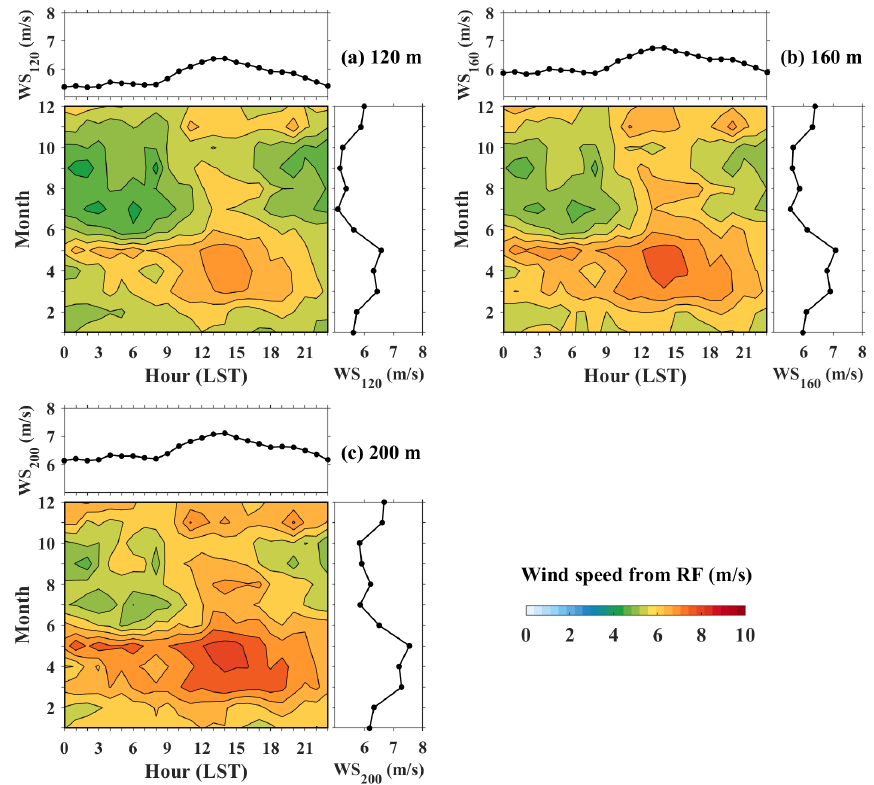
Figure 7. Monthly and diurnal cycles of (a) WS 120 , (b) WS 160 , and (c) WS 200 from 1 May 2018 to 31 August 2020. The color bar represents the wind speed from the RF model. Table 1. Statistics for the Weibull distribution of WS 120 , WS 160 , and WS 200 from 1 May 2018 to 31 August 2020. Height